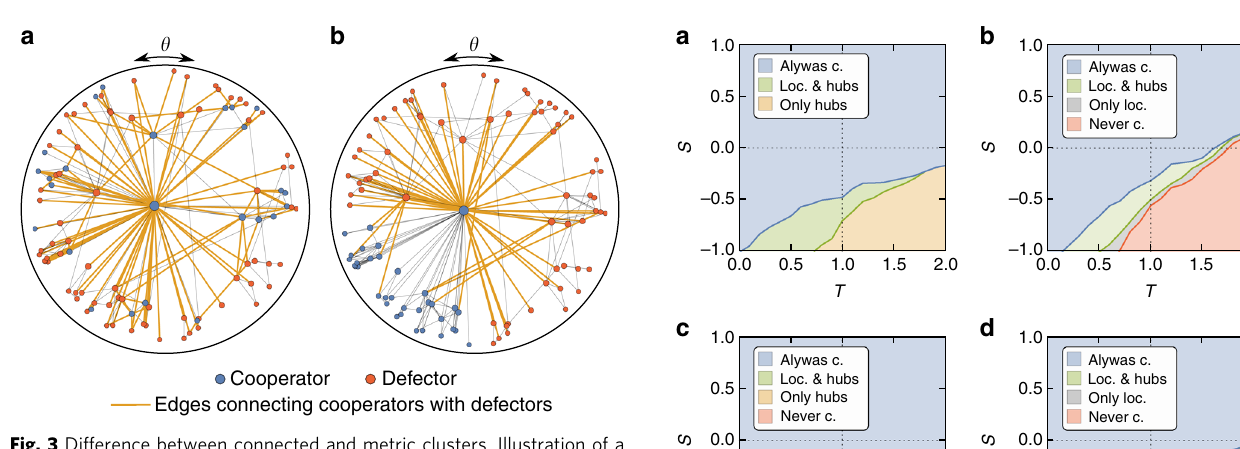
Fig. 3 Difference between connected and metric clusters. Illustration of a connected cluster and a metric cluster using a small network generated with the model described in Methods. a Cooperators (blue nodes) form a connected cluster, which has been assigned following the procedure described in Methods (here we assigned N /4 nodes into the connected cluster). b The same network as in a , but now cooperators form a metric cluster, i.e., their similarity (angular) coordinates θ lie in the interval [ π , 3/